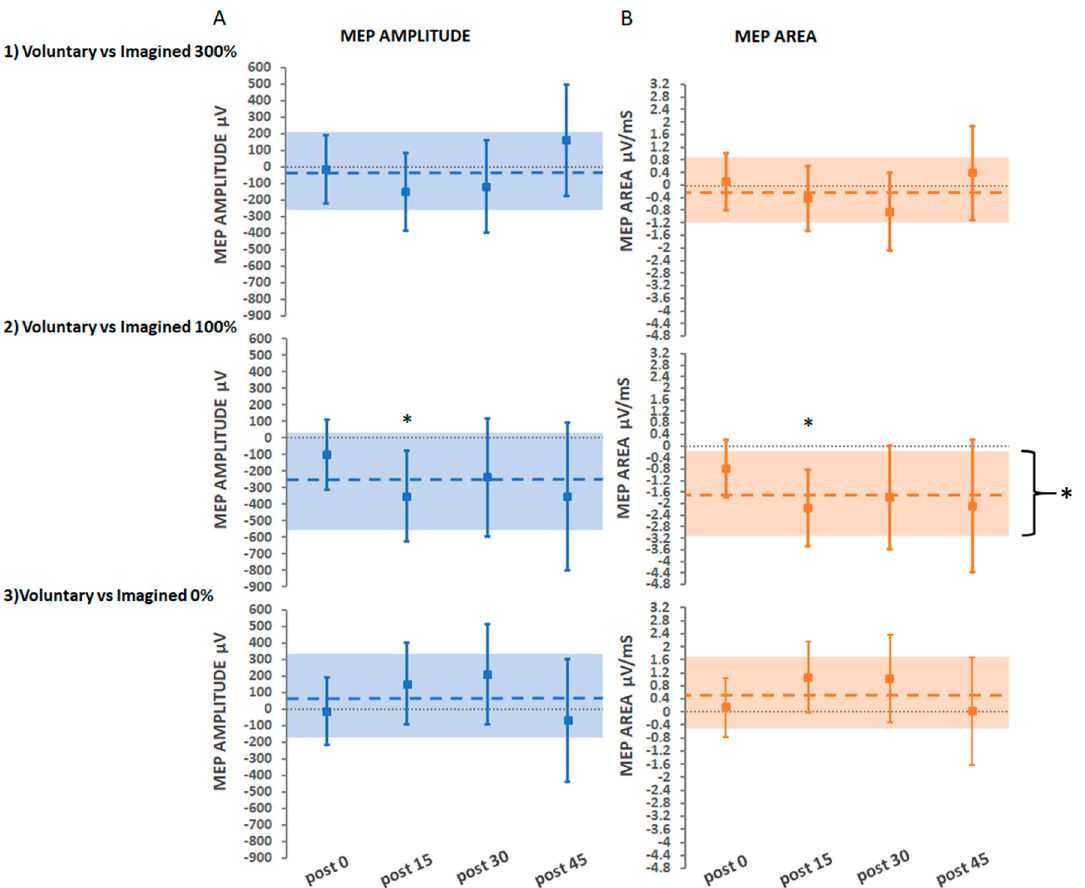
Figure 7. Estimated adjusted effect differences between voluntary and imagined movement at each stimulation intensity level on ( A ) MEP amplitude and ( B ) MEP area, at each post-intervention time-point and averaged over time. Error bars depict 95% CIs. Dashed lines depict averaged over time estimates with a shaded bar for 95% CIs; * indicates significant effects ( p < 0.05).